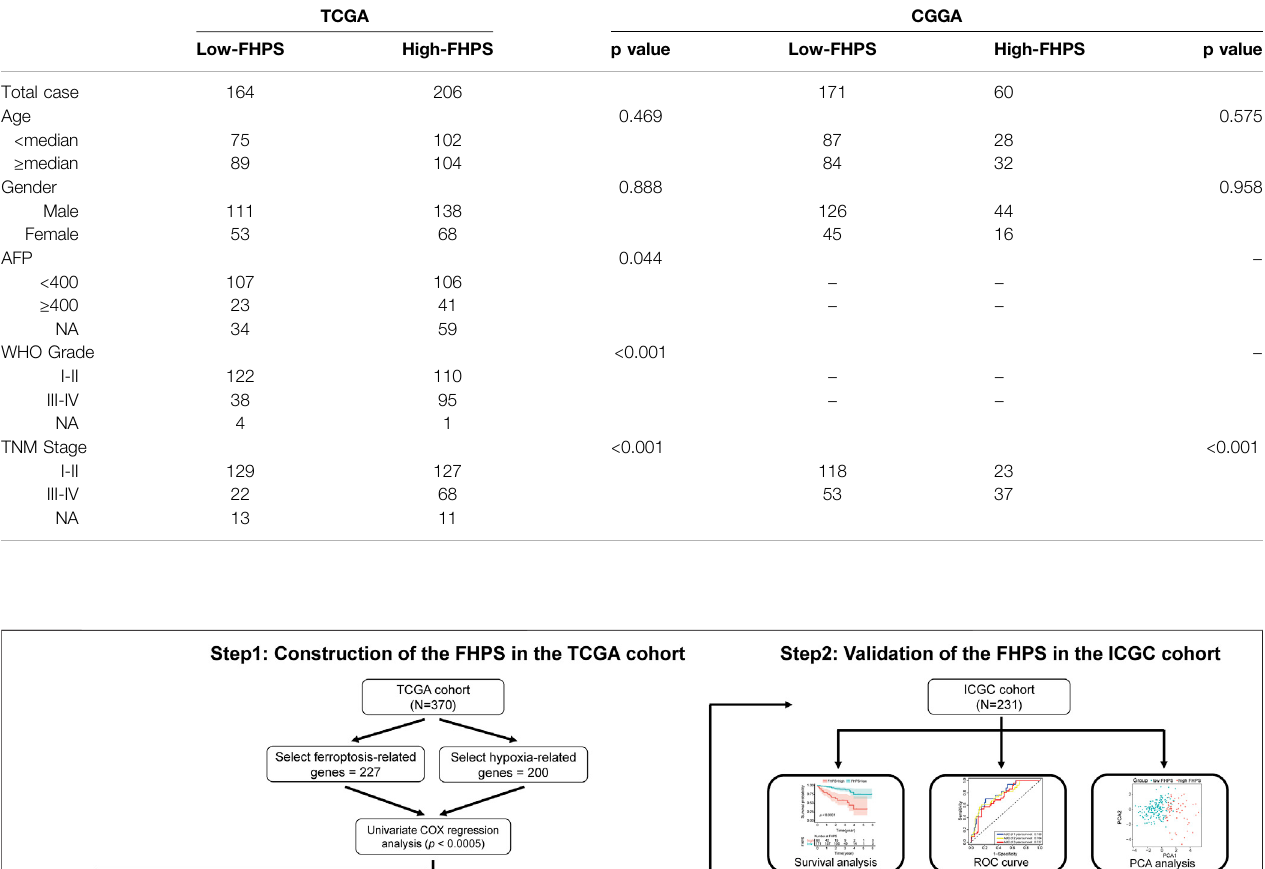
TABLE 2 | Clinicopathological features between low- and high-FHPS groups.